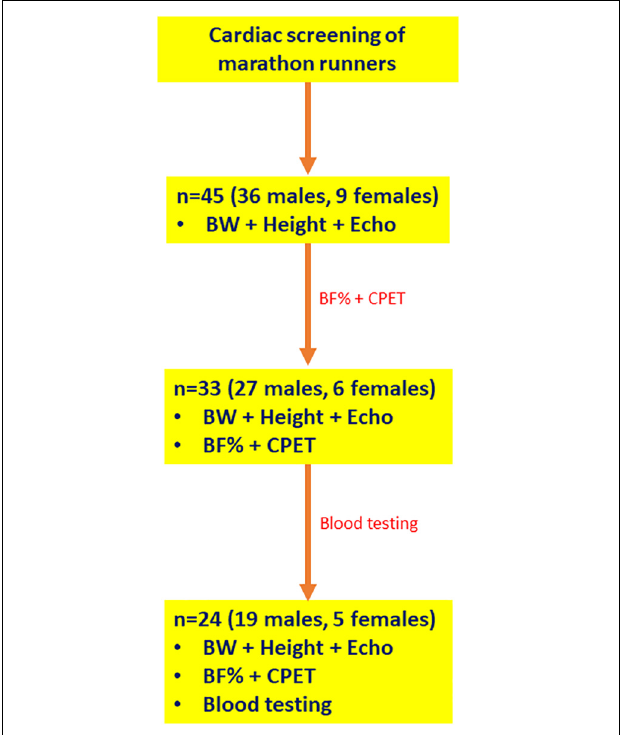
FIGURE 1 | Flowchart showing the selection of study participants. BF%, body fat percentage; BW, body weight; CPET, cardiopulmonary exercise testing; Echo, transthoracic